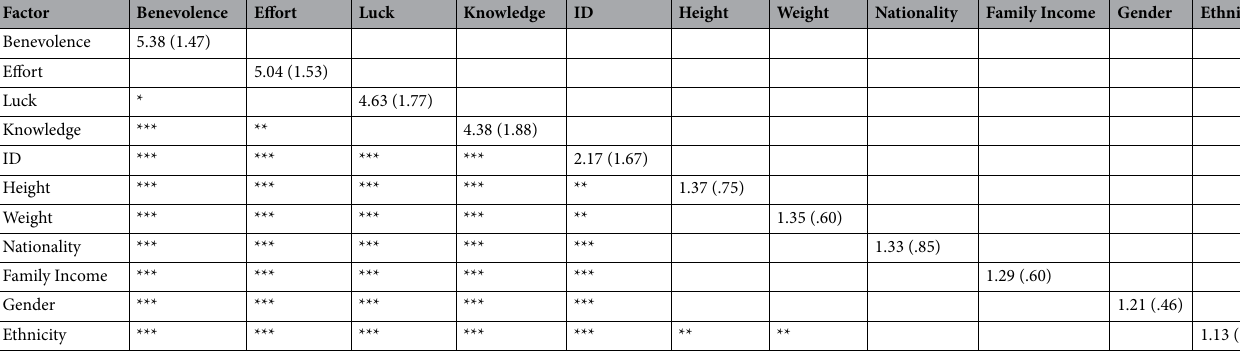
Table 2. Mean fairness and Wilcoxon signed-rank test comparisons. Notes: Standard deviations are indicated in parentheses. Stars in a cell indicate that the factor in the column is fairer than the factor in